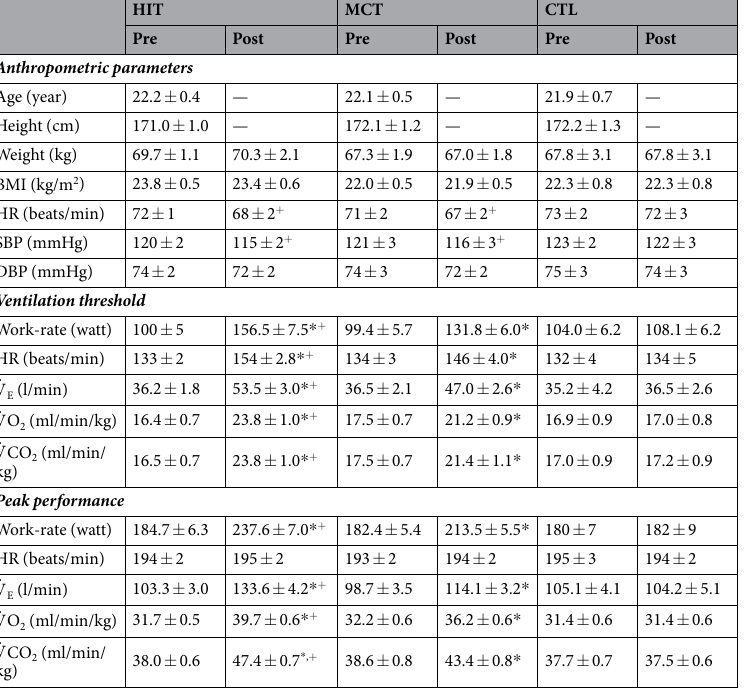
Table 1. The effects of interval and continuous exercise regimens on exercise performance. Values were mean ± SEM. HIT, high-intensity interval training group; MCT, moderate-intensity continuous training group; CTL, control group; Pre, pre-intervention; Post, post-intervention; BMI, body mass index;  V E , minute ventilation;  V O 2 , oxygen consumption;  V CO 2 , carbon dioxide production. * P < 0.05, Pre vs. Post; + P < 0.05, HIT vs.